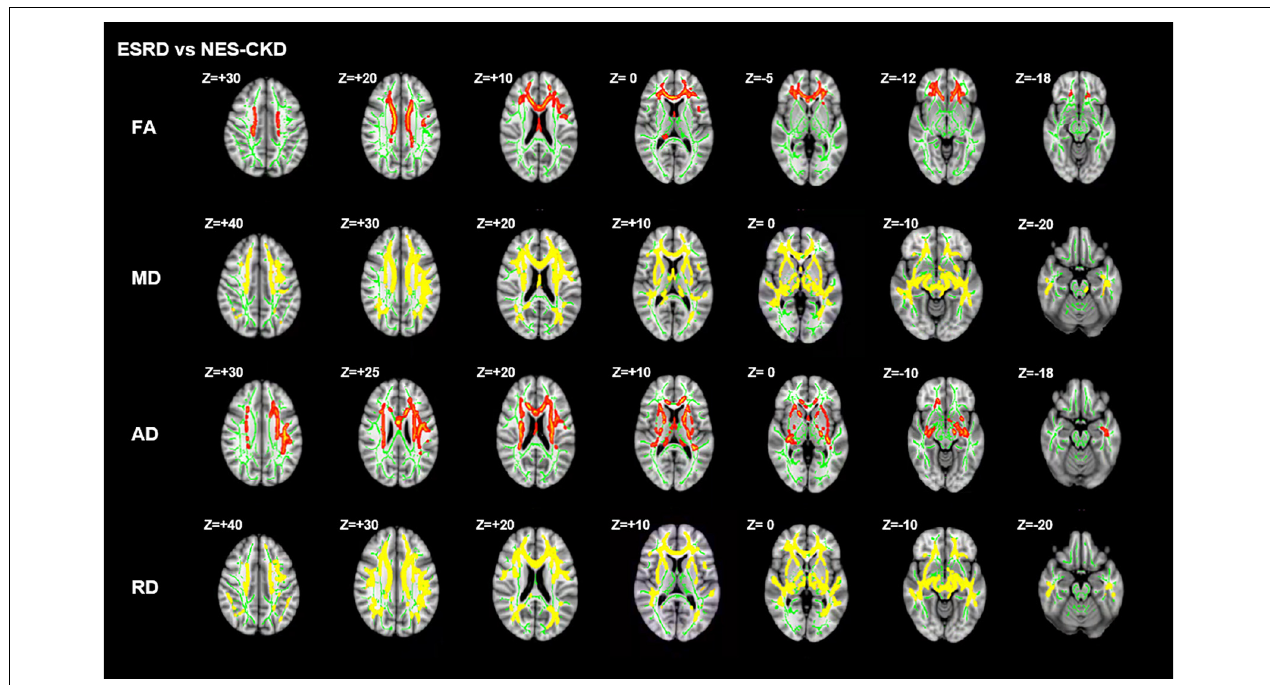
FIGURE 2 | Post hoc analyses result between patients with ESRD and NES-CKD. Green represents the mean FA skeleton of all subjects. Red–yellow represent regions with significant statistical values ( p < 0.05, TFCE-corrected). ESRD, end-stage renal disease; NES-CKD, non-end-stage chronic kidney disease; FA, fractional anisotropy; MD, mean diffusivity; AD, axial diffusivity; RD, radial diffusivity.